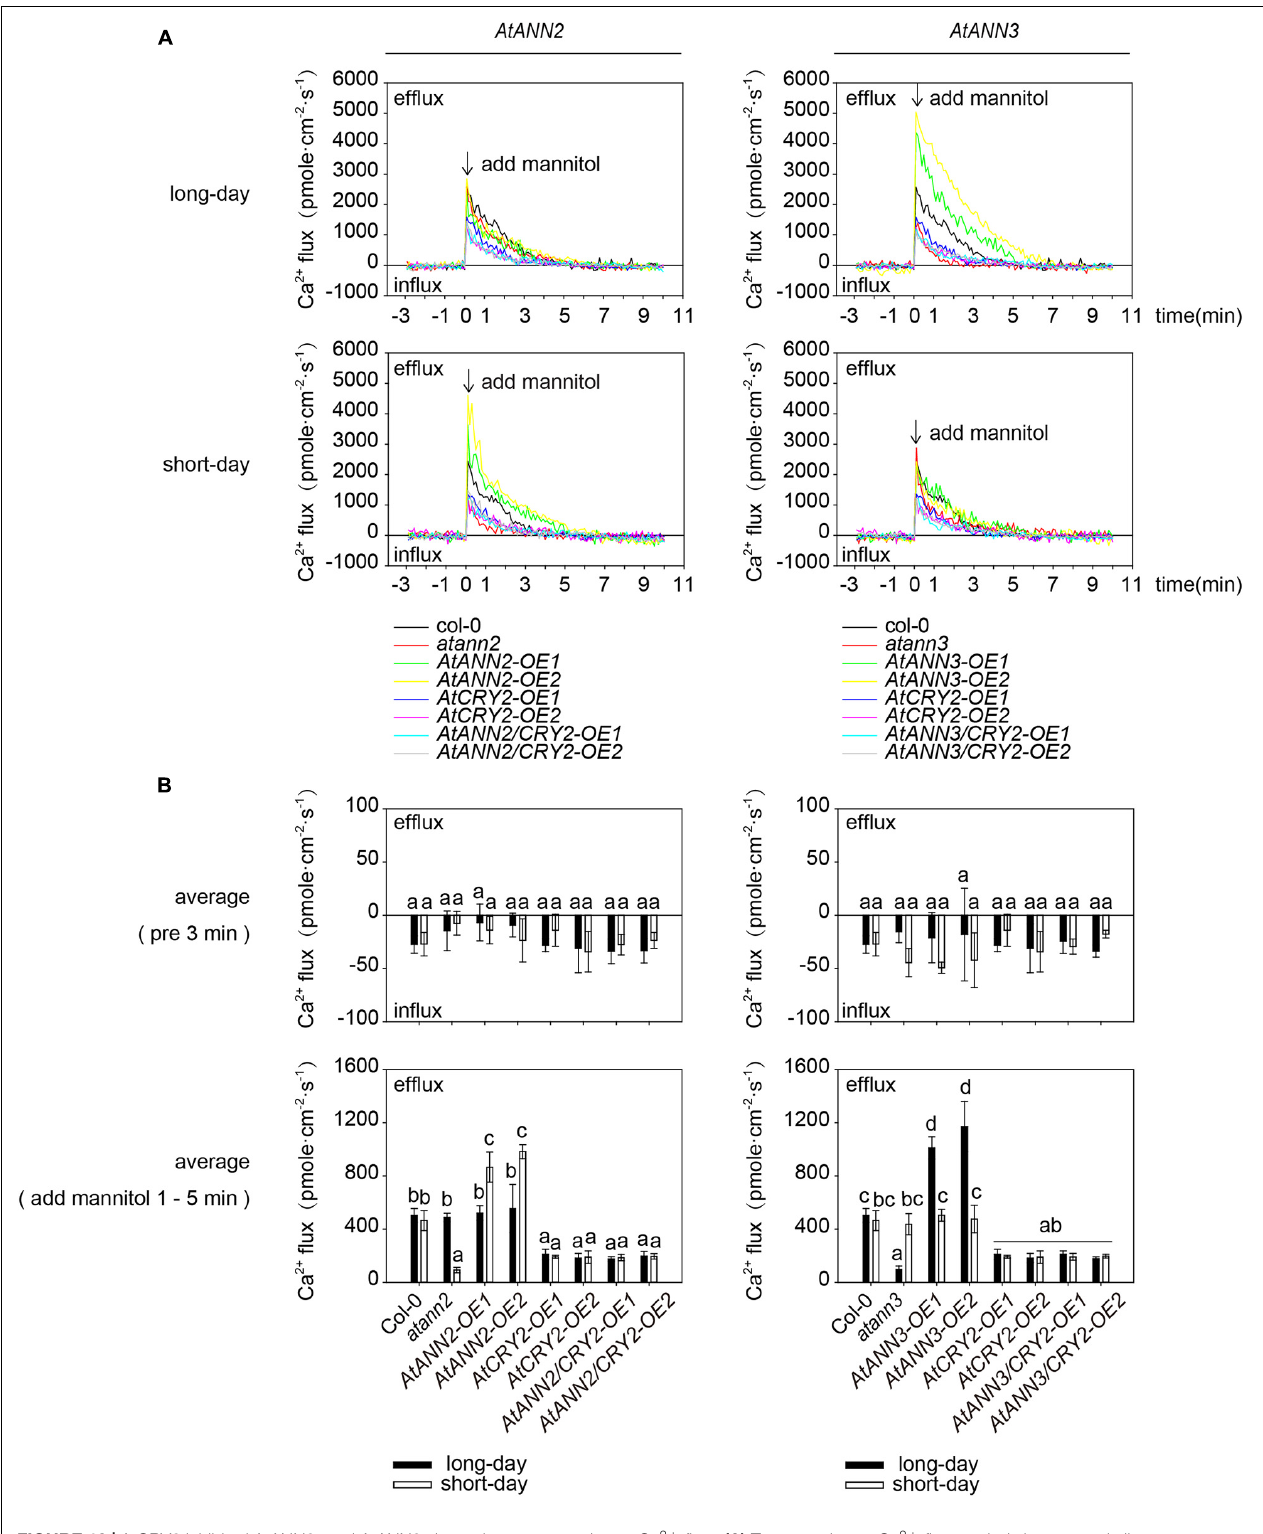
Frontiers in Plant Science |